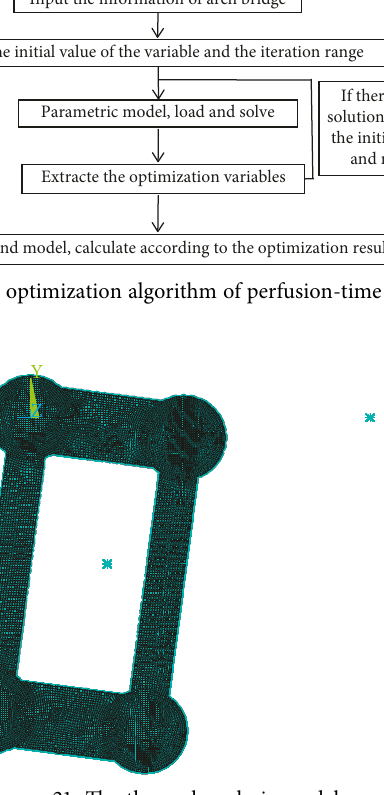
Figure 21: The thermal analysis